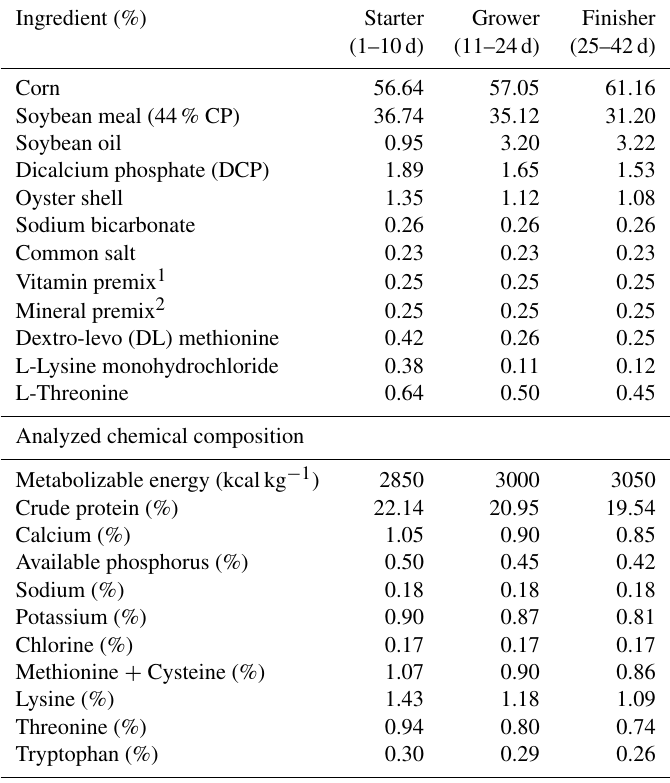
Table 1. Composition of the basal diet (ingredients and nutrients) given to broiler chickens for 6 weeks.